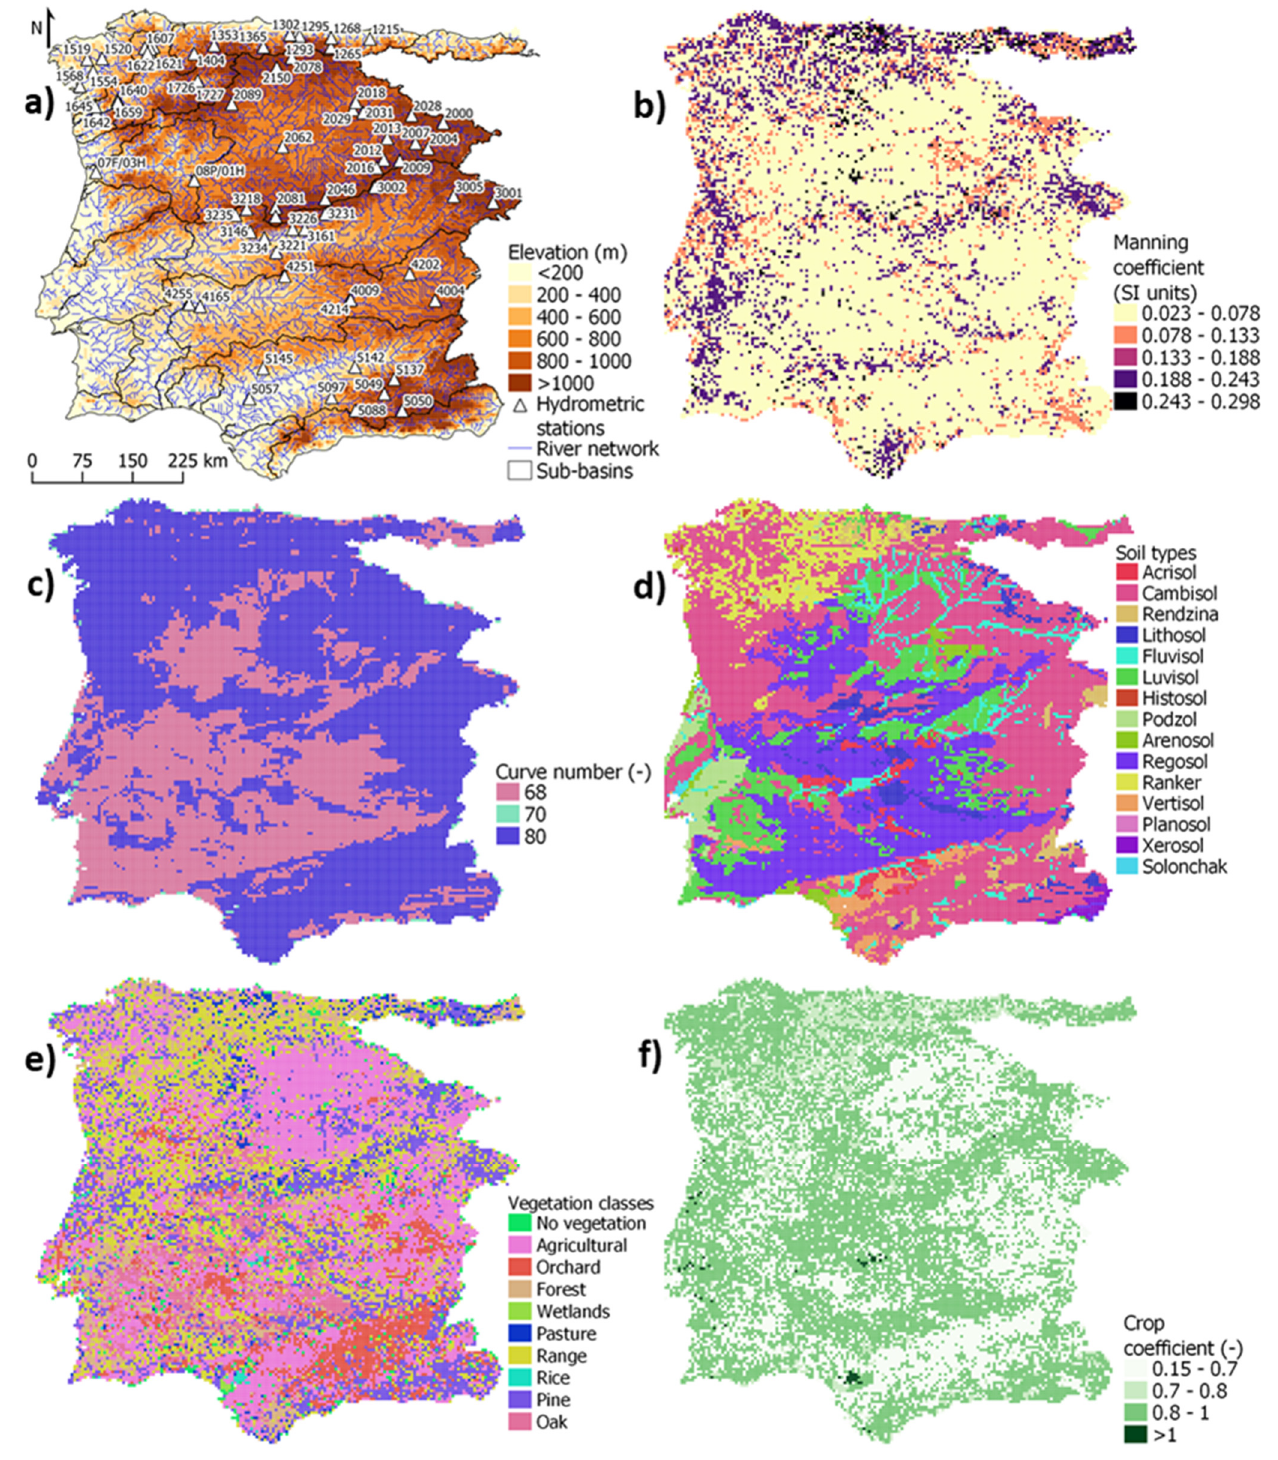
Figure 2. Characterization of the modeled domain: ( a ) digital terrain model, delineated drainage network, and localization of hydrometric stations not influenced by reservoirs with a total capacity larger than 10 hm 3 ; ( b ) surface Manning coefficient; ( c ) curve number values for the SCSCN method; ( d ) major soil units; ( e ) vegetation classes according to the MOHID database; ( f ) crop coefficients. The river network was delineated based on the interpolated DTM, considering the steepest slope in all 8 directions of each cell, by connecting the cell centers (nodes) with the lowest height. The river cross-sections were defined according to the Strahler order of